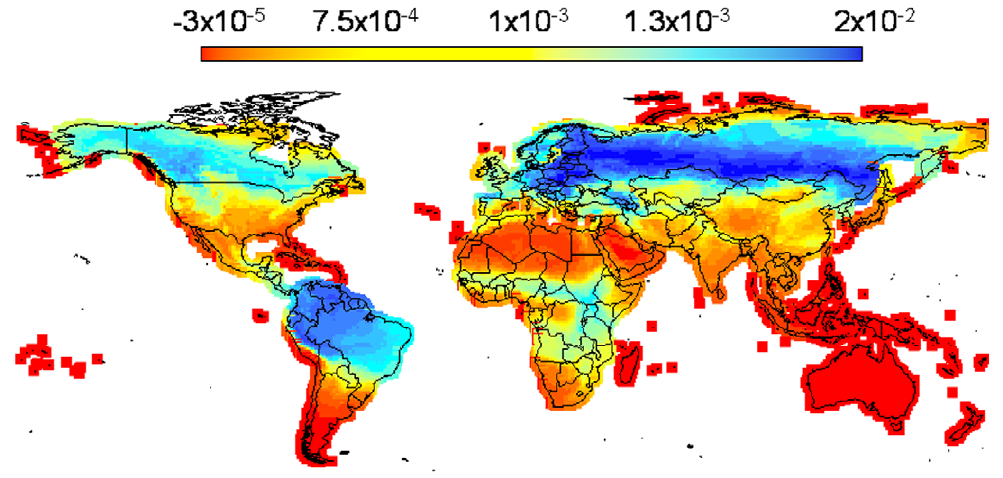
Figure 6. Geographic distribution of the mean covariance for the terrestrial mammals of the world. Notice how the lowest values of covariance (red) tend to occur in islands, mountain ranges and the periphery of continents, while the largest covariances occur in the bulk of continental regions.